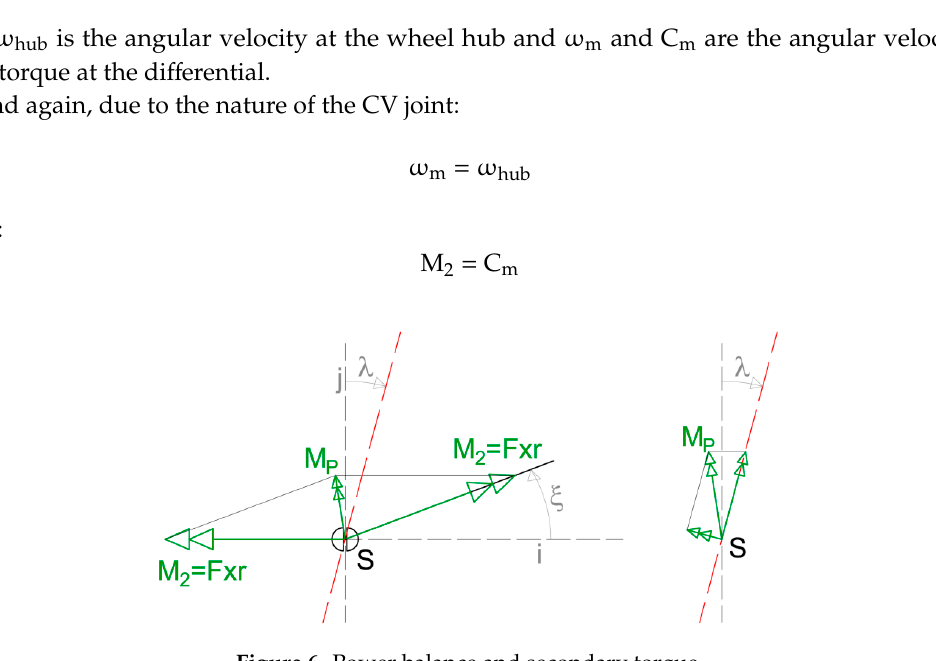
Figure 5. Case 3: inclined half shaft.